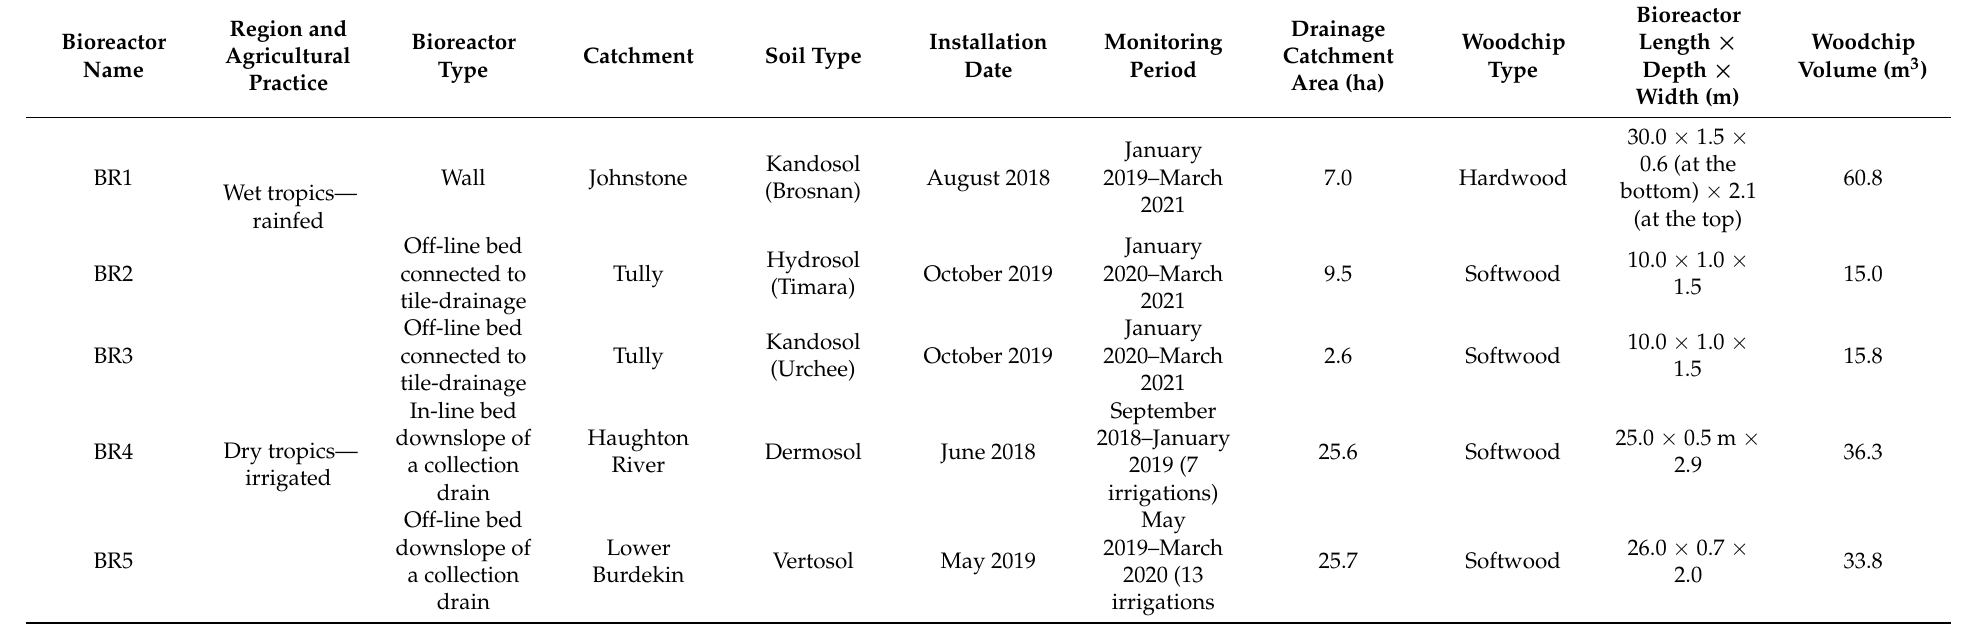
Table 1. Description of the five denitrifying bioreactors installed in the wet tropics and dry tropics regions of North Queensland, Australia. For the description of off-line and in-line beds please refer to Wegscheidl, et al.